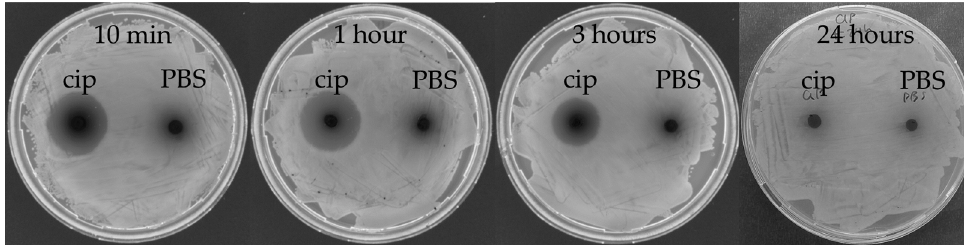
Figure 6. Antibiotic stability in vivo in G. mellonella larvae haemolymph. Ciprofloxacin (cip) at 490 µg/mL was injected in healthy larvae and after 10 min, 1, 3, and 24 h; the haemolymph was collected from one larva. Drops of 10 µL haemolymph were plated on agar and left to dry, after which a loan of E. coli was streaked on top. Inhibition zones were observed the next day. Larvae injected with PBS served as a control. Inhibition zones formed around the haemolymph spot from the antibiotic-injected larvae at 10 min, 1 and 3 h post-injection, but were not present at 24 h. The control haemolymph from the PBS-injected larvae did not form inhibition zones.